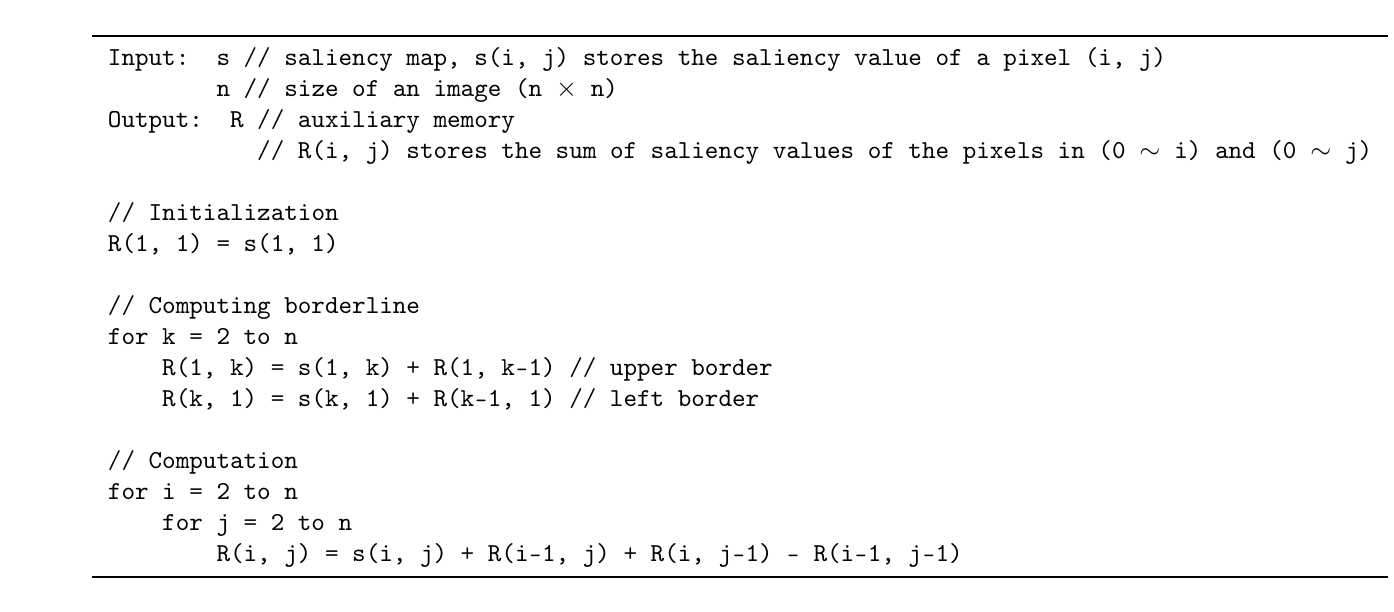
Figure 4. Pseudocode for computing auxiliary memory R from a saliency map s